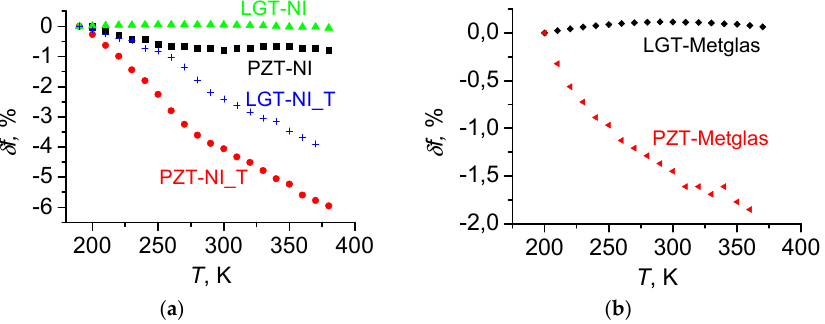
Figure 11. Temperature dependences of the change of the resonance frequency δ f for ME structures with different compositions comprising Ni ( a ) or Metglas layers ( b ). The index “_T” designates structures with the thickness of a Ni layer of 200 μ m.